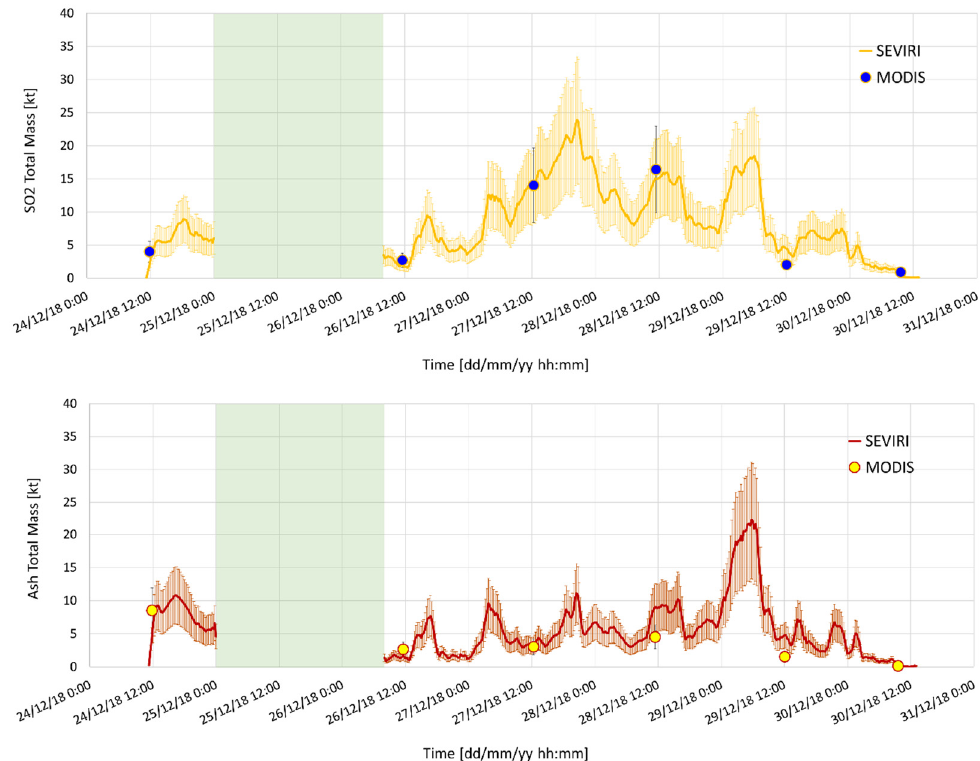
Figure 11. SO 2 (upper plot) and ash (lower plot) total mass retrievals obtained from SEVIRI and MODIS. The vertical bars represent the SEVIRI retrieval uncertainties.